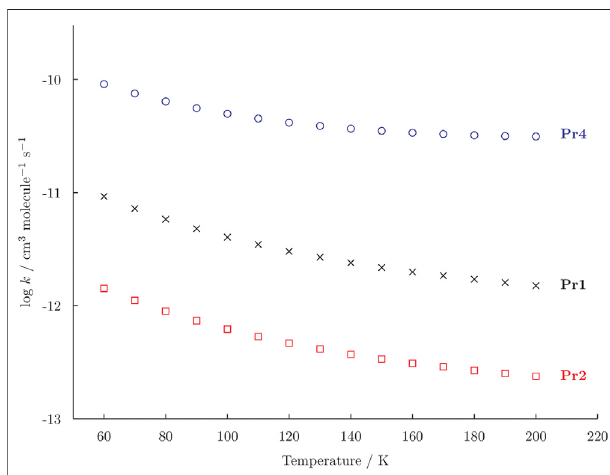
FIGURE 2 | Rate constants ( k ) for the formation of Pr1 (black crosses), Pr2 (red squares), and Pr4 (blue dots) computed in the temperature range 60 – 200 K. The vertical axis is reported as logarithmic